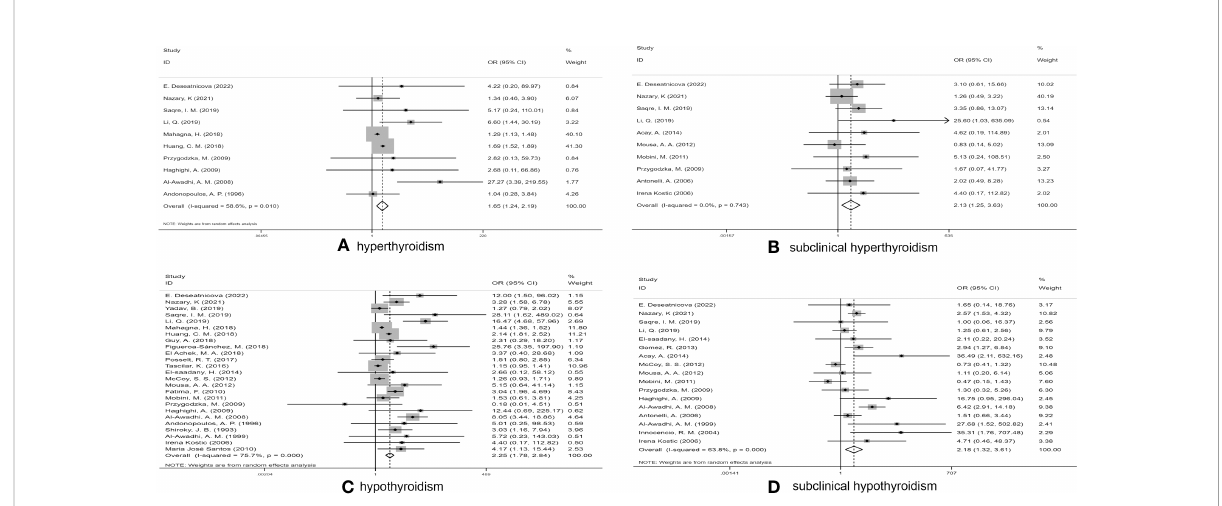
FIGURE 2 Forest plot for the risk of thyroid dysfunction among RA patients. (A) Forest plot for the risk of hyperthyroidism among RA patients, (B) Forest plot for the risk of subclinical hyperthyroidism among RA patients, (C) Forest plot for the risk of hypothyroidism among RA patients, (D) Forest plot for the risk of subclinical hypothyroidism among RA